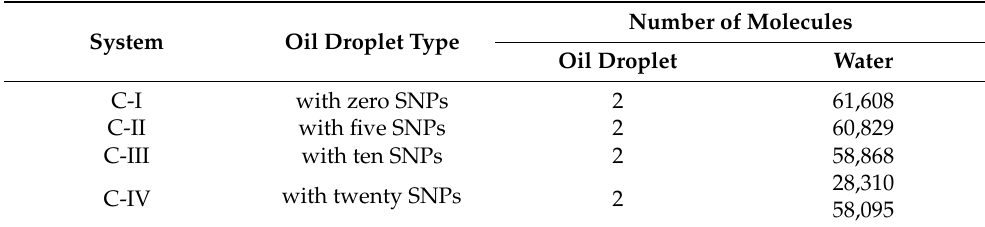
Table 2. Details of the emulsification systems for investigating the influence of SNPs on oil droplet coalescence.